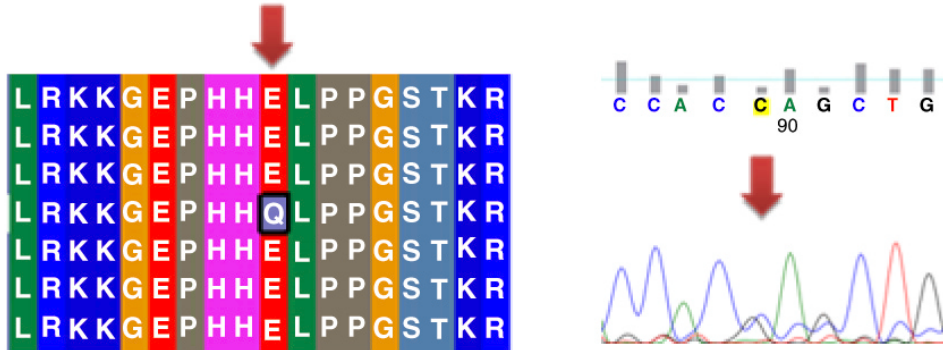
Figure 8. Mutation of glutamic acid into glutamine at position